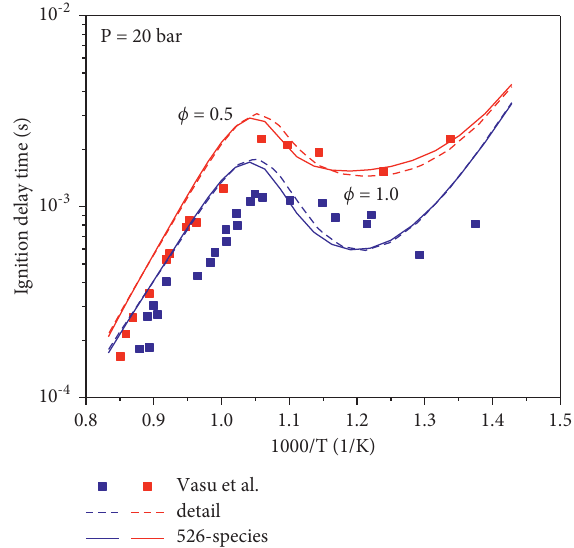
Figure 1: Ignition delay times validation for n-dodecane. The experimental data used for comparison were taken from Vasu et al. [46].